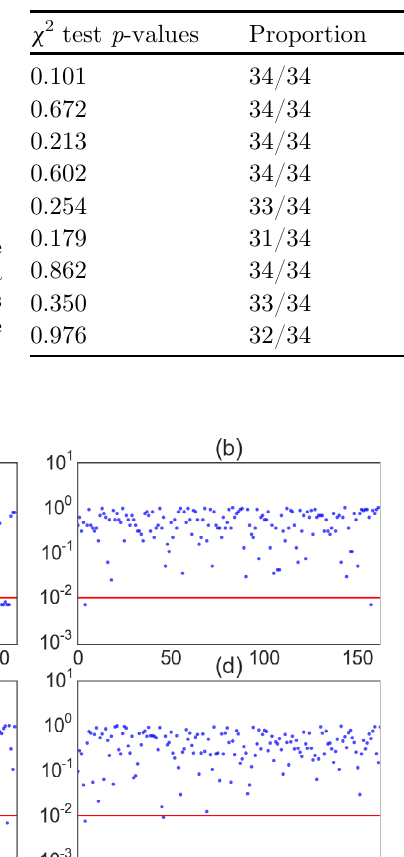
Table 1. Partial results of the NIST suite for our unbiased binary sequence.